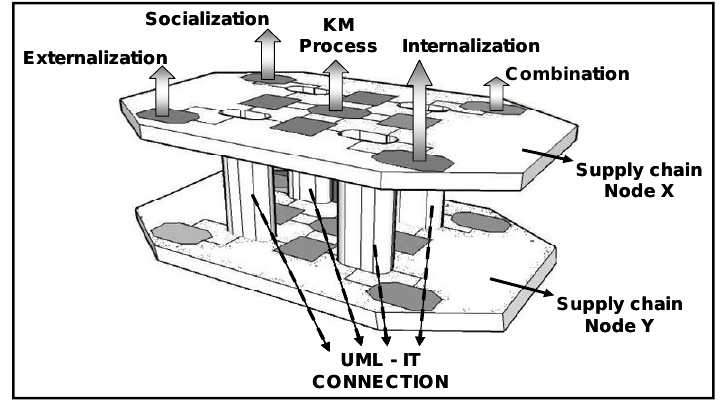
Figure 2. “Extended KMF to support the collaborative process in the SC by UML (a dyadic